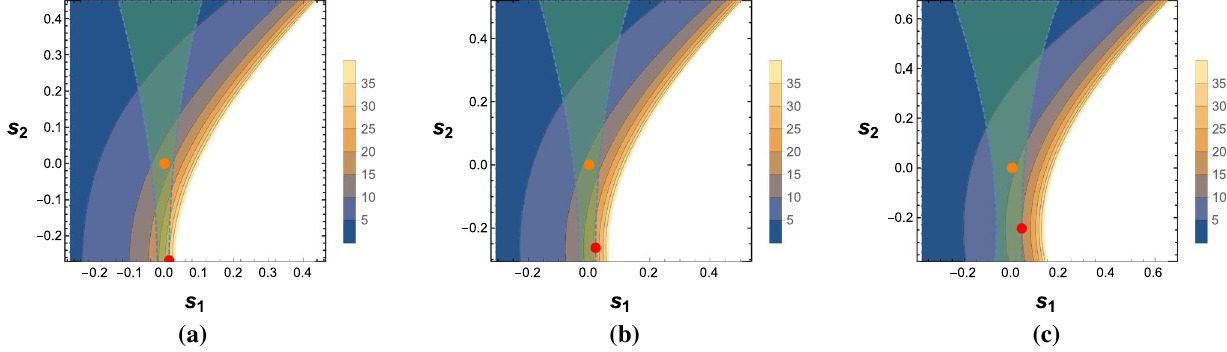
for the non-spinning case, E 3 max ≈ 12 . 66. b when n = 0.3, for the spinning case, E